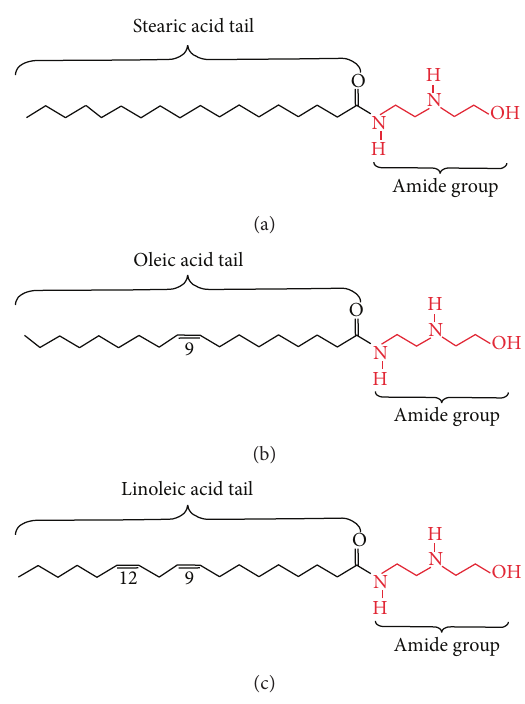
Figure 1: Molecular structure of the fatty-amides evaluated: (a) stearic amide (18:0), (b) oleic amide (18:1 n-9), and (c) linoleic amide (18: 2